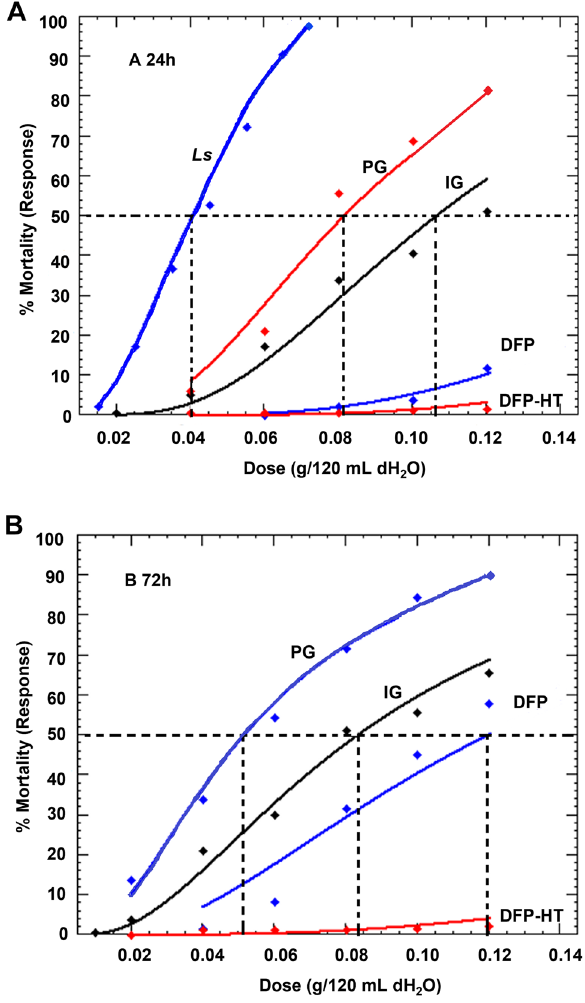
Figure 1. Mortality curve estimated by the dose–response (Probit) of Ae. aegypti larvae (3rd larval instars) to seed meal concentrations 24 h ( A ) and 72 h ( B ) post treatment. Broken lines represent the LC 50 of seed meal